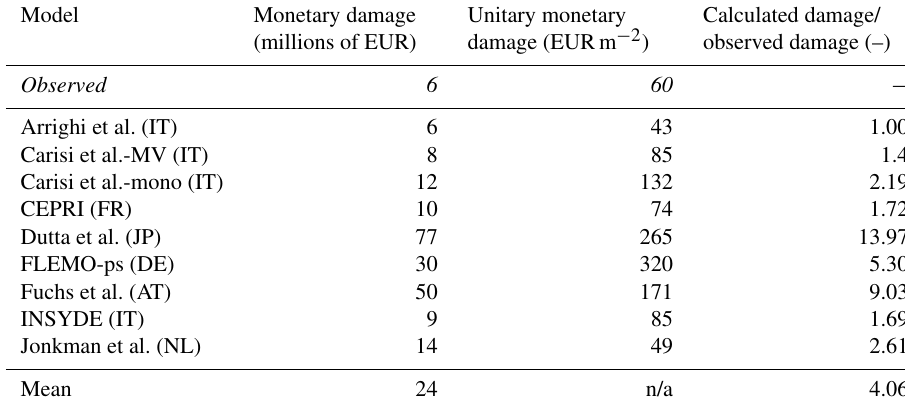
Table 4. Observed damage data vs. estimates of the total monetary damage for the subset of buildings with claims (n/a: not applicable). The second and the third columns report, respectively, the total damage and the unit value of damage per square metre. Mean value of estimates is reported in the last row. The fourth column reports the ratio between estimates and observed damage. Suffixes are used to track the original country of the models (IT: Italy; FR: France; JP: Japan; DE: Germany; AT: Austria; NL: the Netherlands). Model Monetary damage Unitary monetary Calculated damage/ (millions of EUR) damage (EURm − 2 ) observed damage (–) Observed